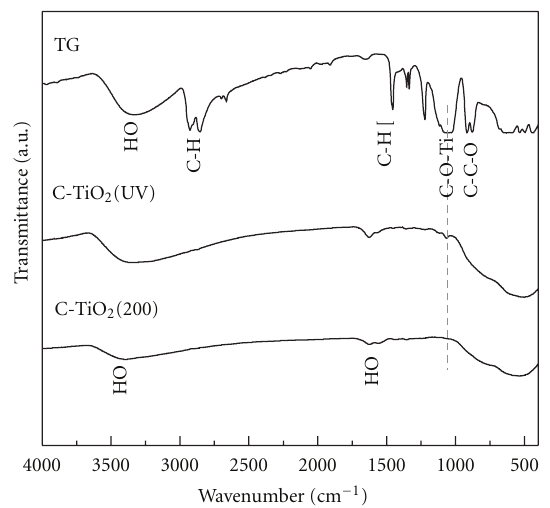
Figure 4: The IR spectra of TG, C-TiO 2 (UV), and C-TiO 2 (200).